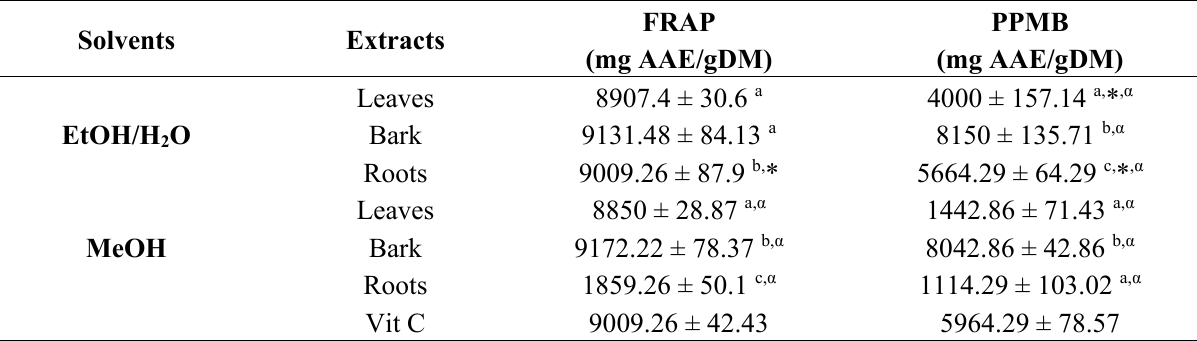
Table 4. Variation antioxidant capacity of extracts of S.